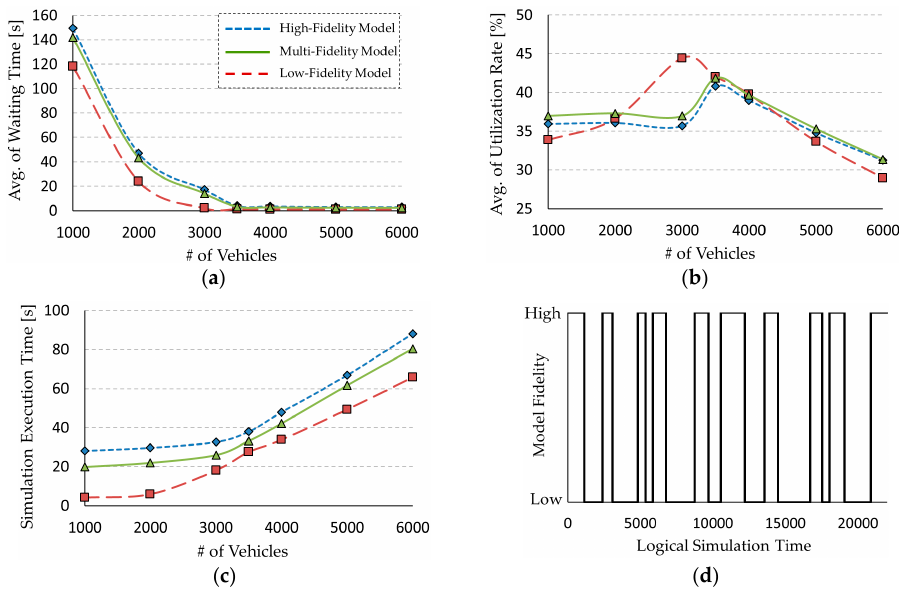
Figure 19. Simulation results for the UTV simulation: ( a ) average waiting time of passengers according to the number of vehicles; ( b ) average utilization rate of vehicles according to the number of vehicles; ( c ) simulation execution time according to the number of vehicles; ( d ) frequency of fidelity exchange in the multi-fidelity UTV model.